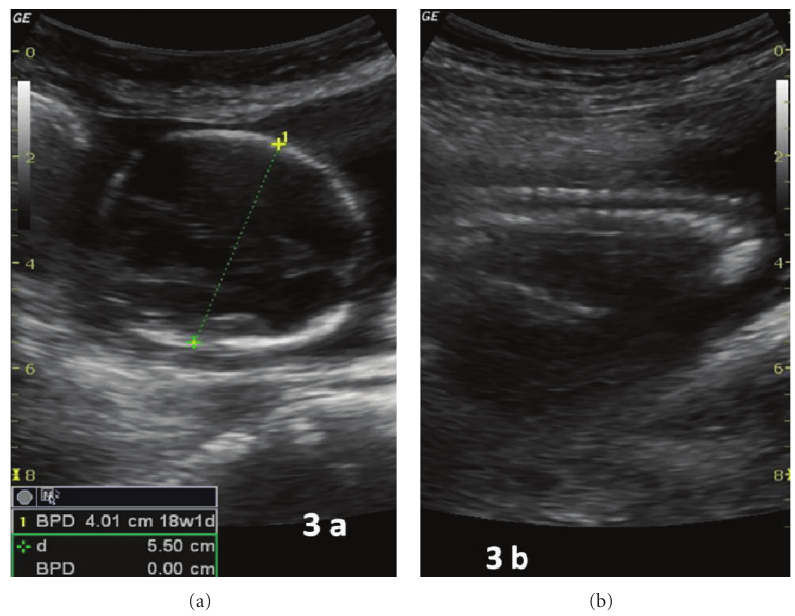
Figure 3: (a) Fetal head lying in peritoneal cavity; (b) fetal spine lying in peritoneal cavity.